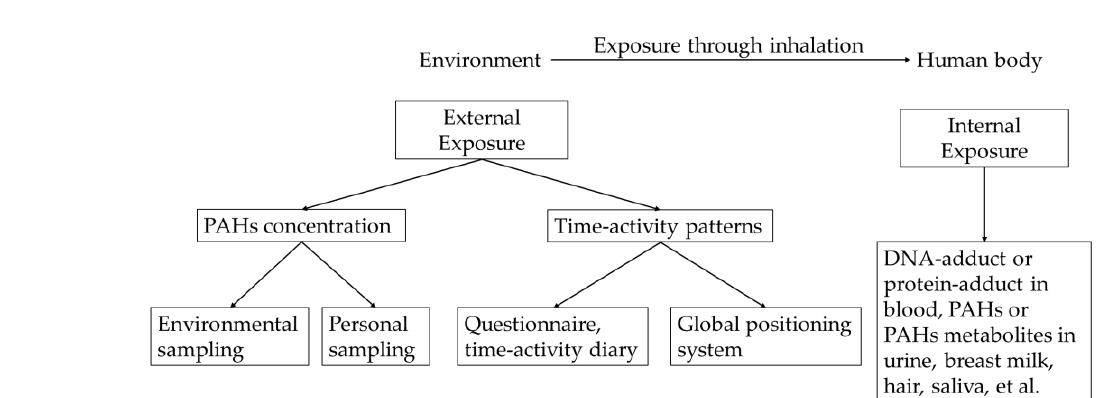
Figure 1. Flow chart of evaluation methods for polycyclic aromatic hydrocarbons (PAHs) exposure.